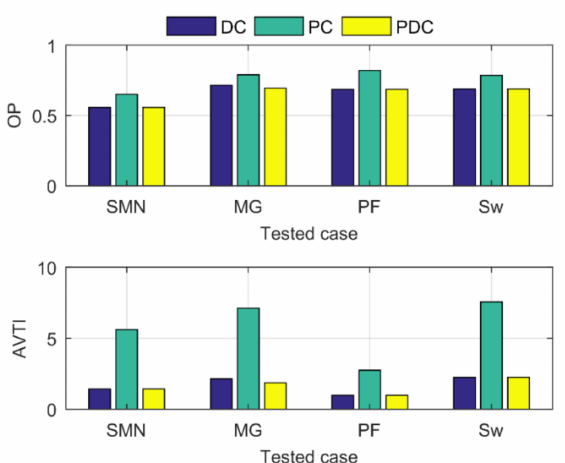
Figure 6. Performances of data rectification of bias detection criteria of modified EM approach. SMN: steam metering network; MG: metallurgical grinding; PF: Pai-Fisher; Sw: